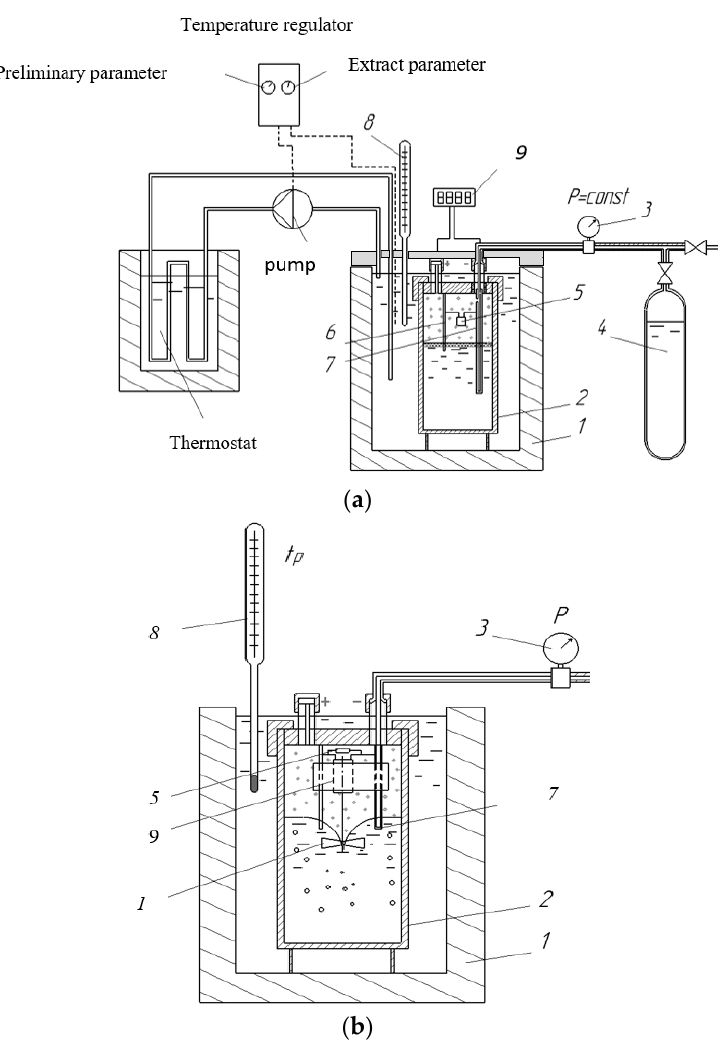
Figure 1. Experimental plant with temperature stabilization of hydrate formation: ( a )-diffusion hydration; ( b )-replaceable module for the study of hydrate formation with the application of a high-speed mixer: 1-insulated housing; 2-capacity for high pressure; 3-manometer; 4-high pressure gas; 5-electronic temperature sensor: 6, 7-electrodes; 8-thermometer; 9-high-speed microelectric motor; 10-mixer impeller (gravity is not taken into account).